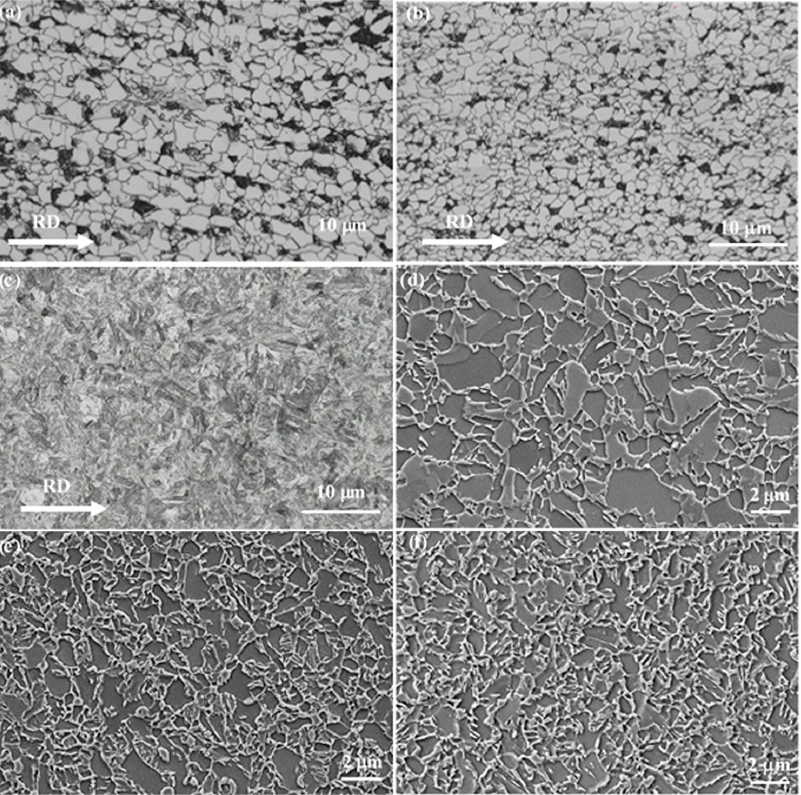
Figure 1. OM and SEM micrographs of microstructures. OM micrographs of ( a ) as-air cooled microstructure after CHR for CHR-Q&P steel, ( b ) as-air cooled microstructure after AHR for AHR-Q&P steel, ( c ) as-direct quenched microstructure after AHR for AHR-DQ-Q&P steel; SEM micrographs of final microstructures for ( d ) CHR-Q&P, ( e ) AHR-Q&P and ( f ) AHR-DQ-Q&P samples.